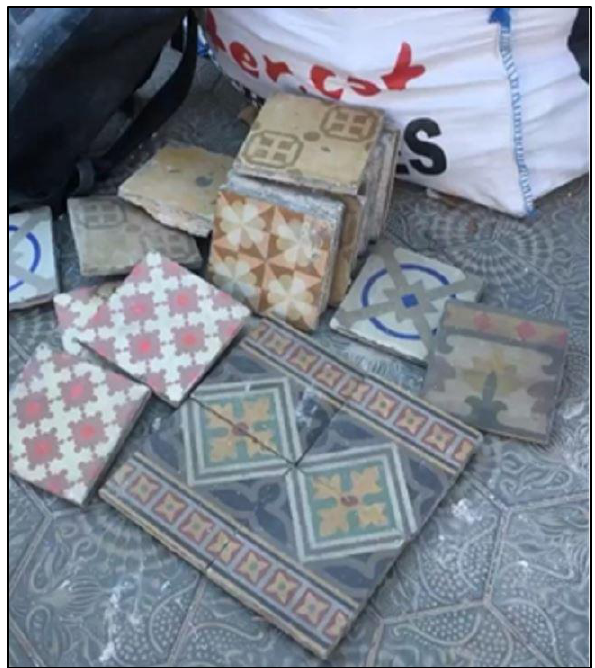
Figure 6 . MCU (left), camera (center) and sensor (right) mounted on a tailored carrier to be inserted into the head of the system. The arm mounted on the far right hosts the lighting sub- system (not shown).